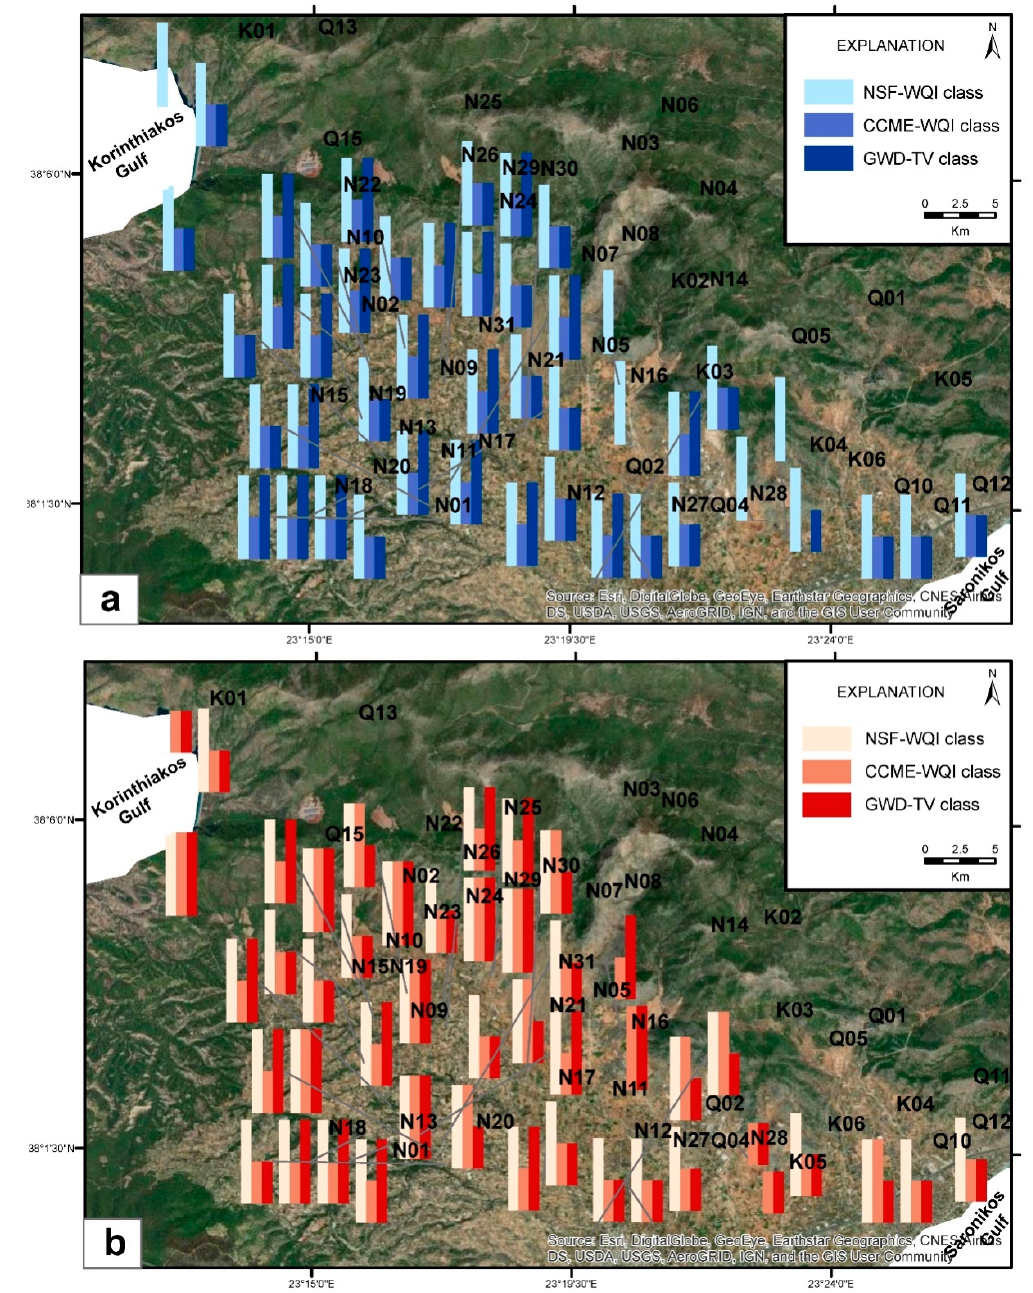
Figure 4. Spatial variation of classes in monitoring stations for the ( a ) wet and ( b ) dry periods.